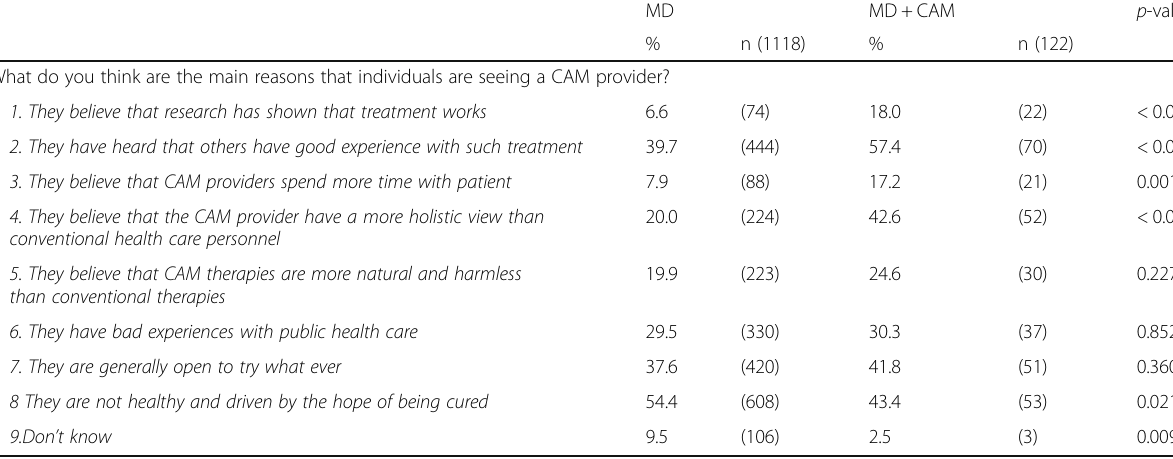
Table 3 Expected reasons for CAM use